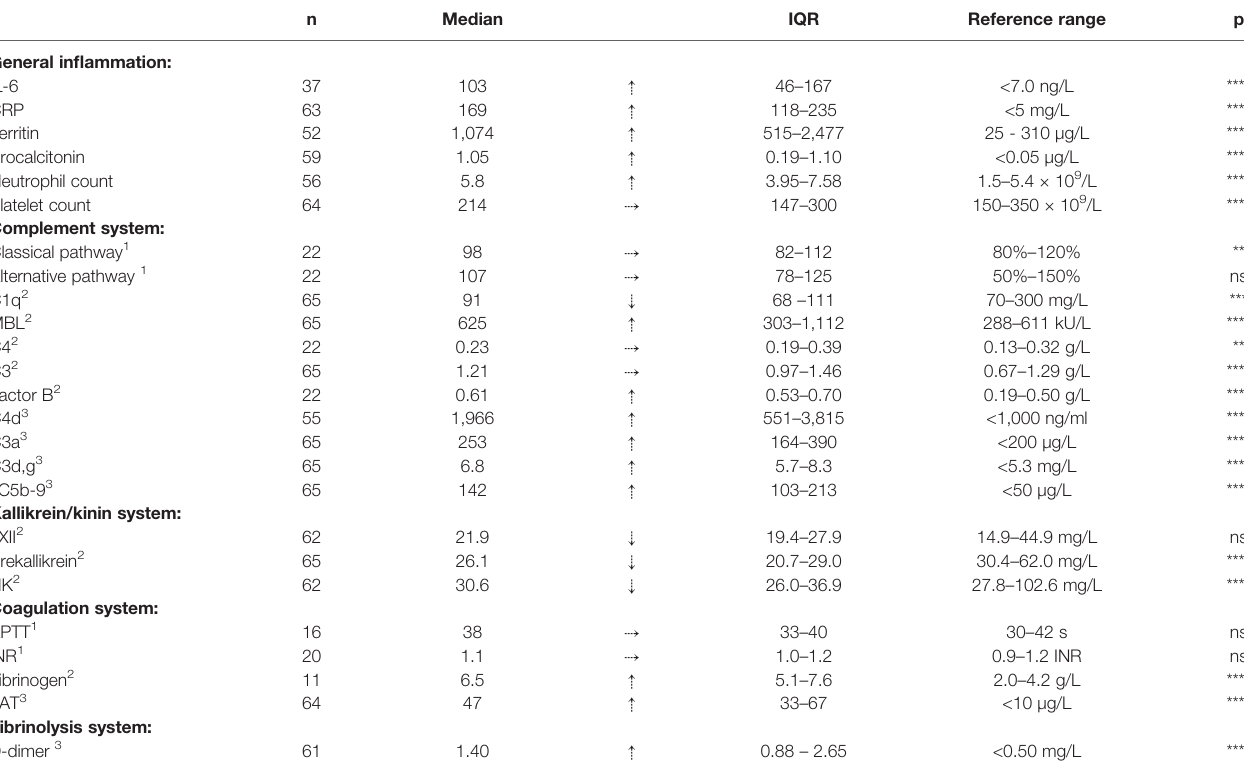
TABLE 2 | Thromboin fl ammatory parameters in serum/plasma at admission to the ICU (n ≤ 65). n Median IQR Reference range